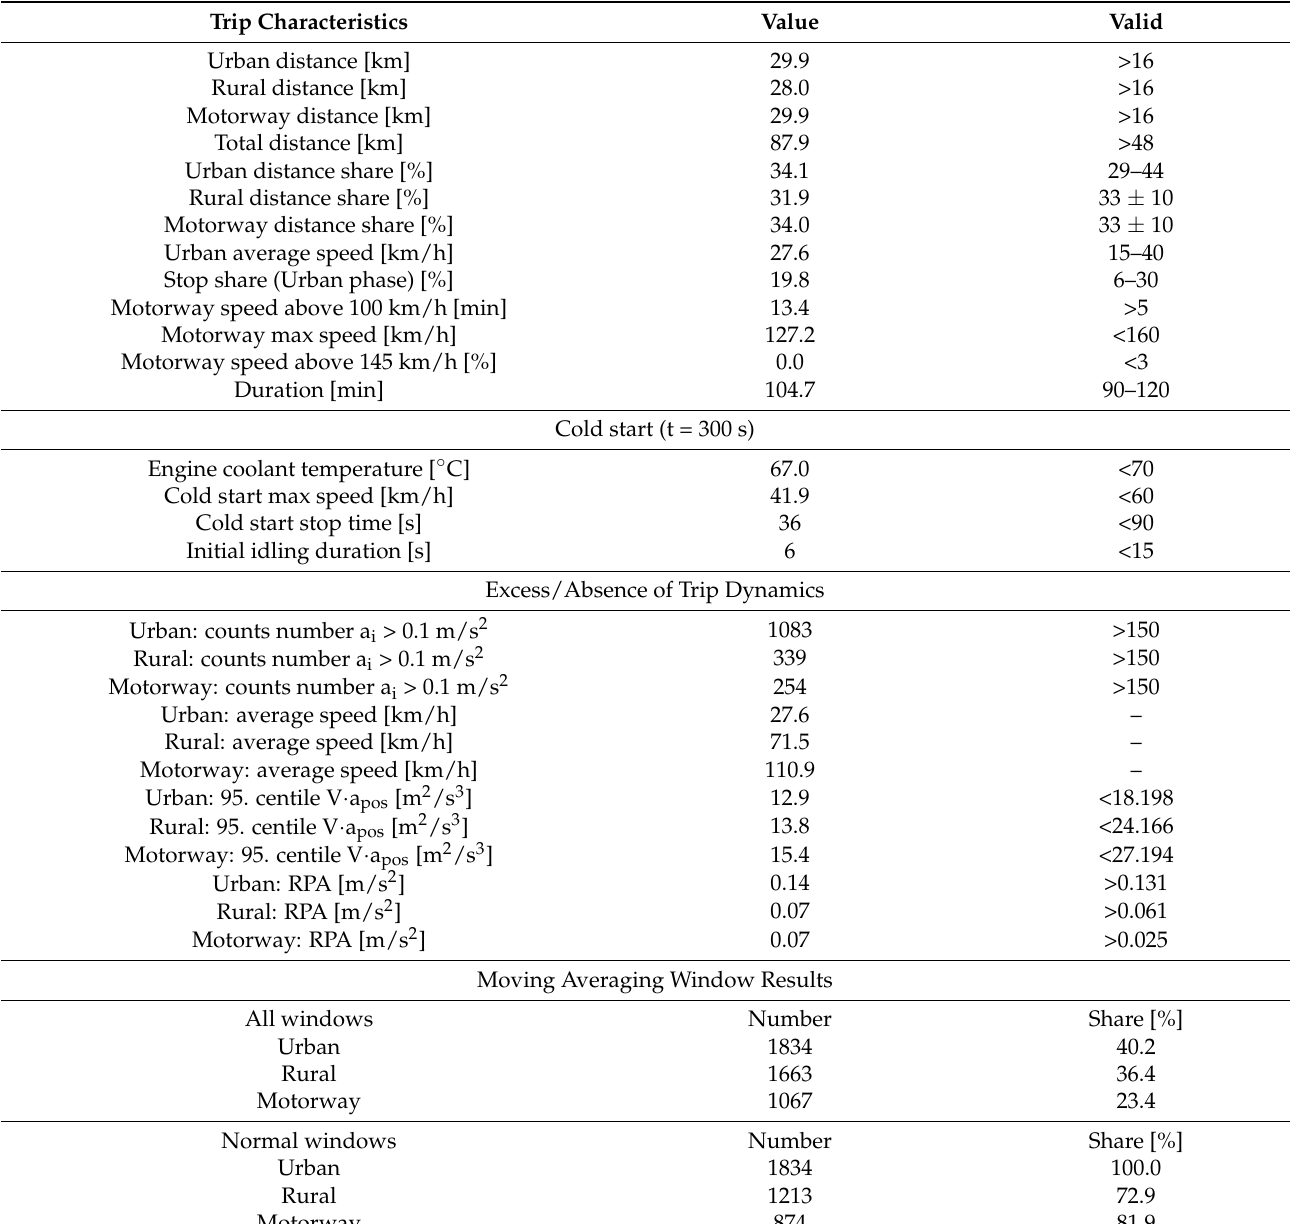
Table A1. Detailed data regarding one of the RDE tests conducted as an example for the tested passenger vehicle with a gasoline engine. Trip